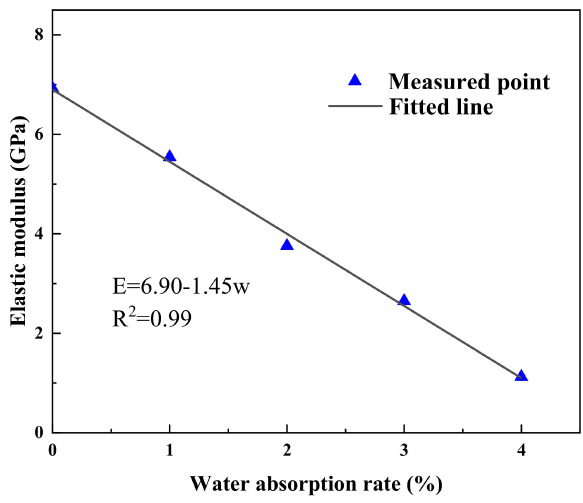
Figure 9. Relationship between the elastic modulus and moisture absorption